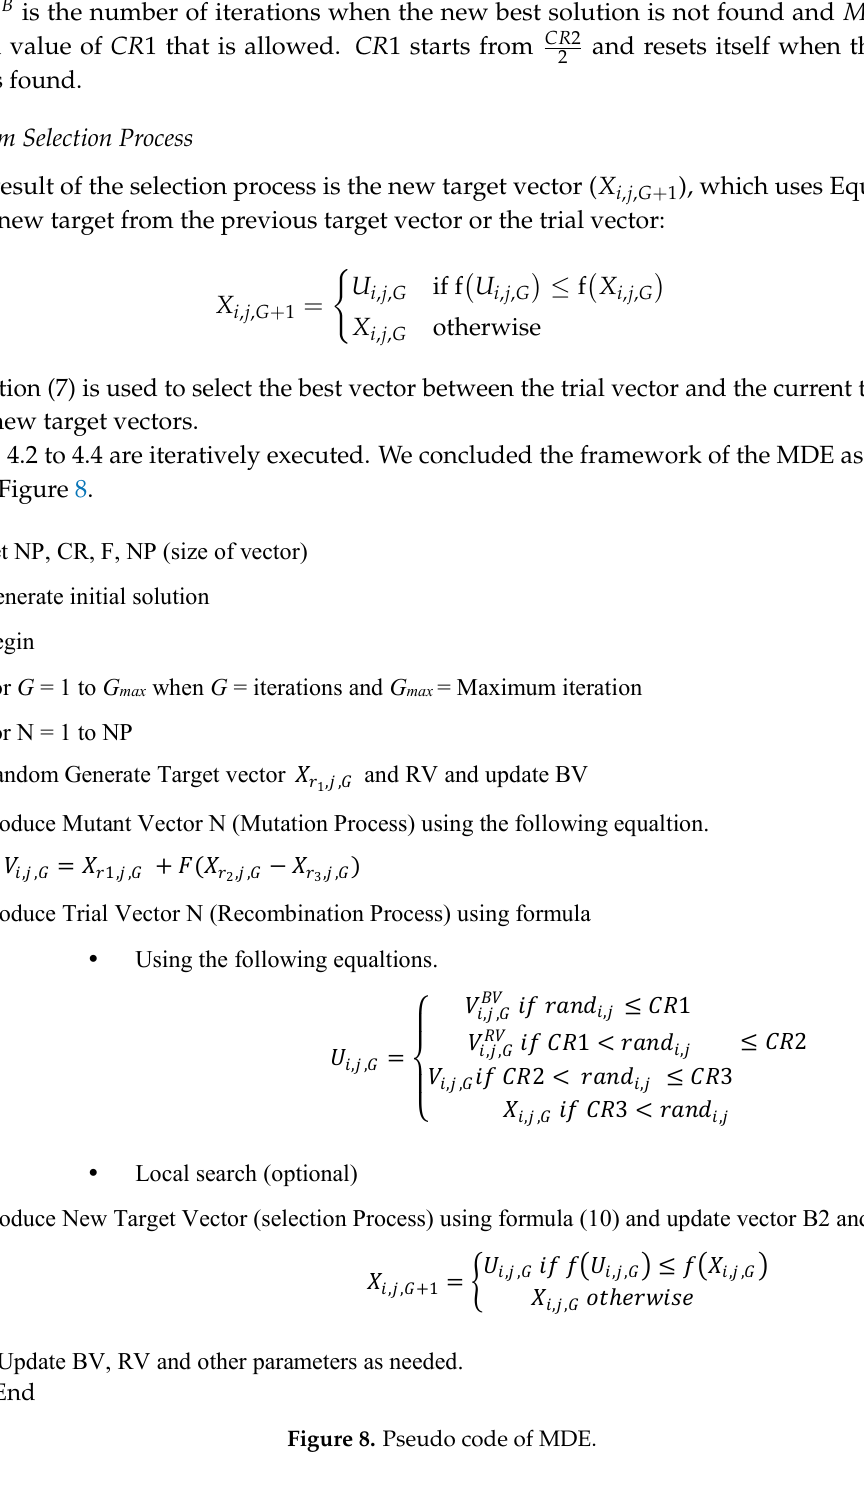
Figure 8. Pseudo code of MDE.